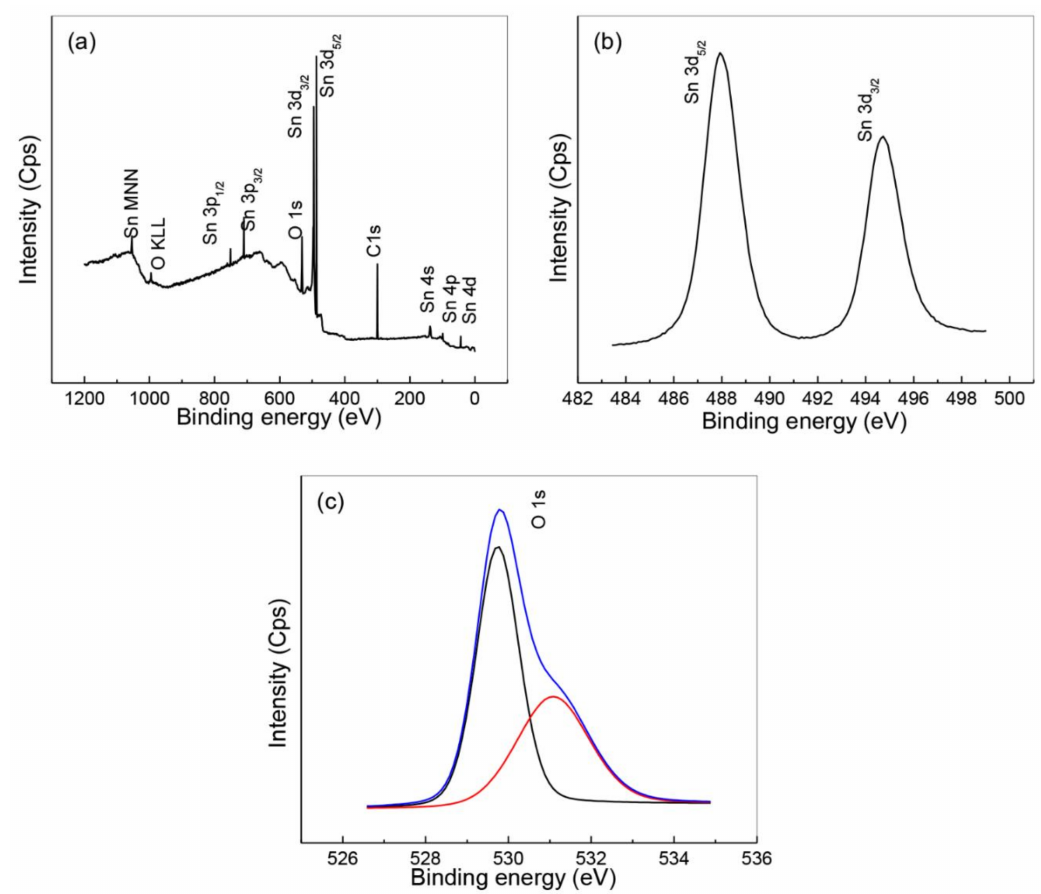
Figure 7. Nanoparticle XPS spectra for survey ( a ), tin ( b ), and oxygen ( c ).